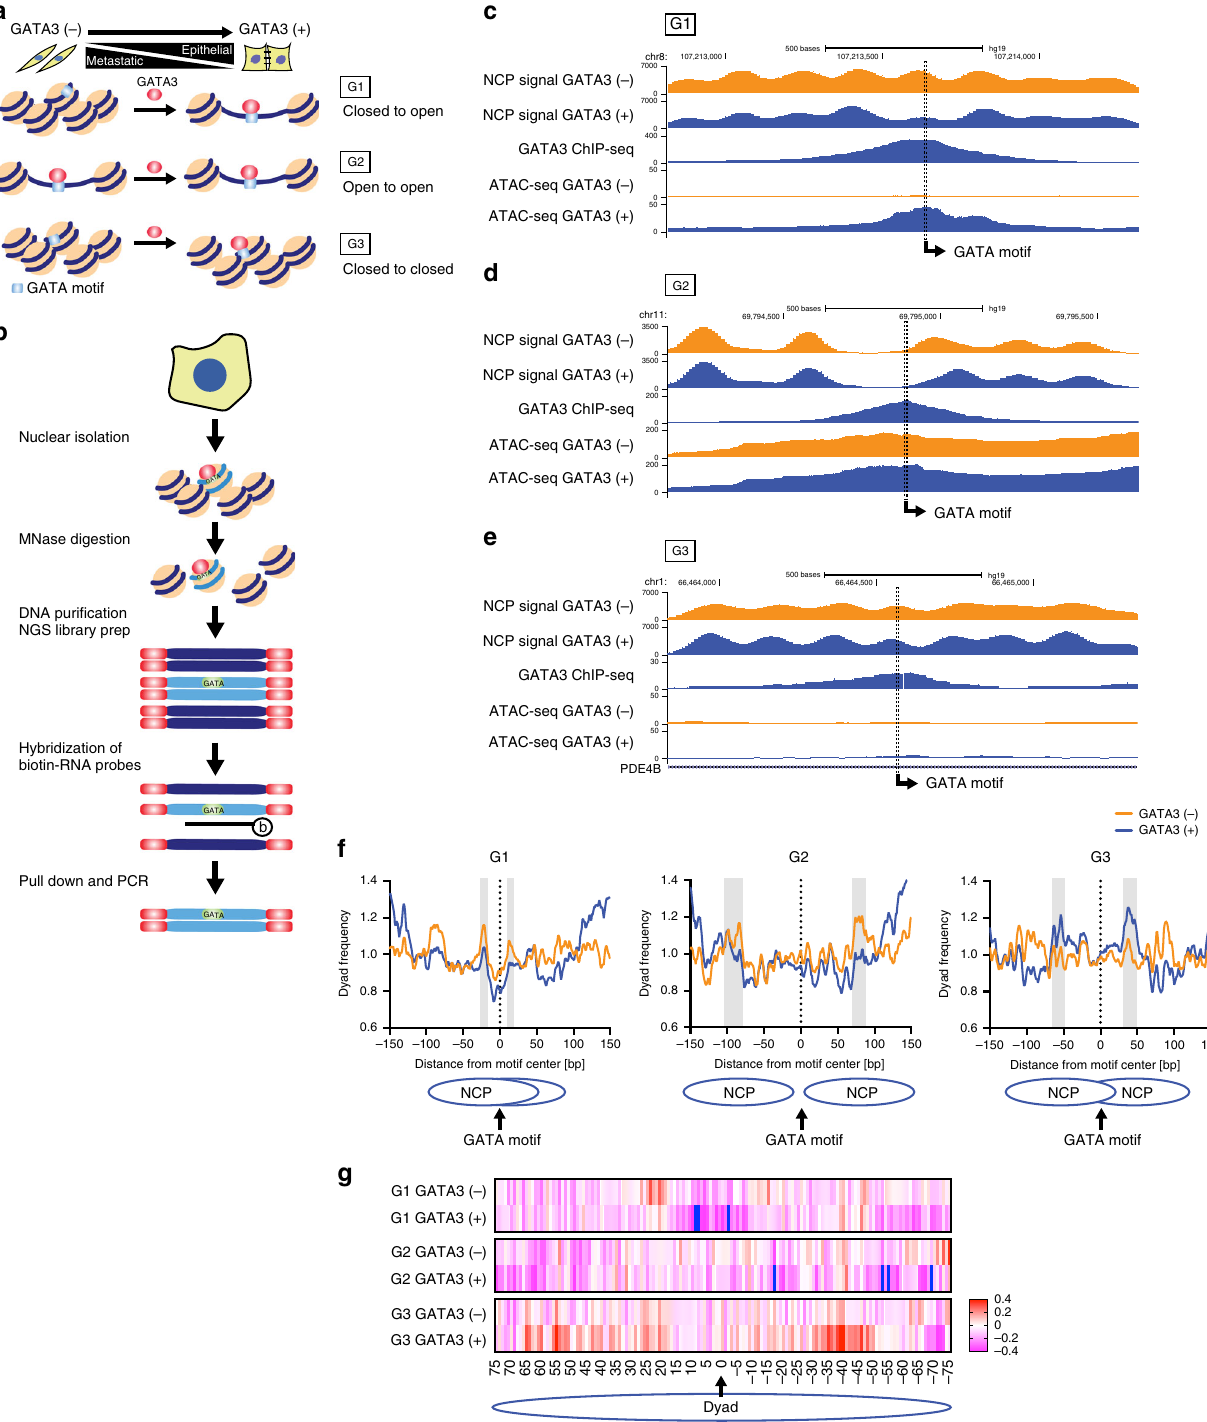
Fig. 1 Nucleosome positioning at GATA3-binding peaks. a GATA3 peak classi fi cation based on chromatin architecture. b Scheme of capture MNase-seq. Targeted GATA3 peaks were enriched with biotinylated RNA probes. Smoothed nucleosome signals (NCP signal) were calculated by iNPS 16 . c – e Genome browser view of capture MNase-seq data at G1 ( c ), G2 ( d ), and G3 ( e ). The dashed squares indicate the closest GATA motifs (from the highest ChIP-seq signals). f Metaplot showing averaged dyad (fragment center/midpoint) frequency in each GATA3 peak group obtained by capture MNase-seq. Dyad frequency was normalized by the capture MNase-seq data from sonicated DNA fragments. Ellipses indicate enriched symmetric positioning of nucleosomes in each peak class. g Heatmap showing enrichment of preferred GATA3 motif positioning on the nucleosome. Frequency of observed GATA3 motif positioning within the nucleosome was normalized by the capture MNase data from the sonicated DNA fragments and the calculated fold changes in each peak group and cell line are indicated as log2 values. Only one GATA3 motif that is closest from the highest GATA3 ChIP-seq signal intensity was chosen from each